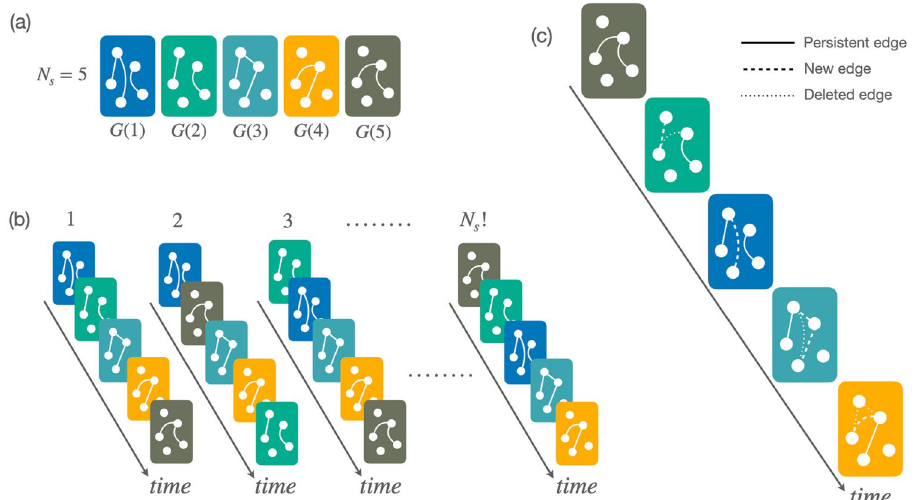
Figure 1. Schematic illustration of the basic features of our framework. ( a ) A simple collection of N s = 5 snapshot graphs constituting the building-blocks of a time-varying network. In ( b ), the former snapshots are randomly shuffled yielding different instances of the time-varying graphs. The real graph corresponds to one of the N s ! possible orderings. Finally, in ( c ) we analyse a given sequence of snapshots comparing each